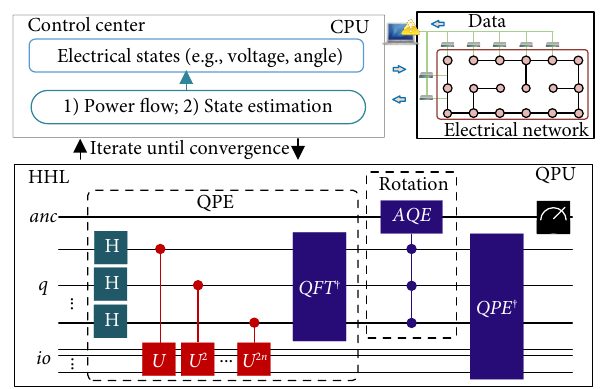
Fig. 2 Quantum circuit architecture for quantum-inspired power grid static analytics [12, 13]